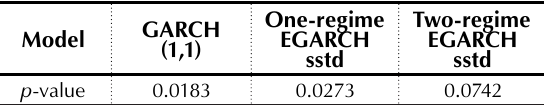
Table 4. Results of the backtest